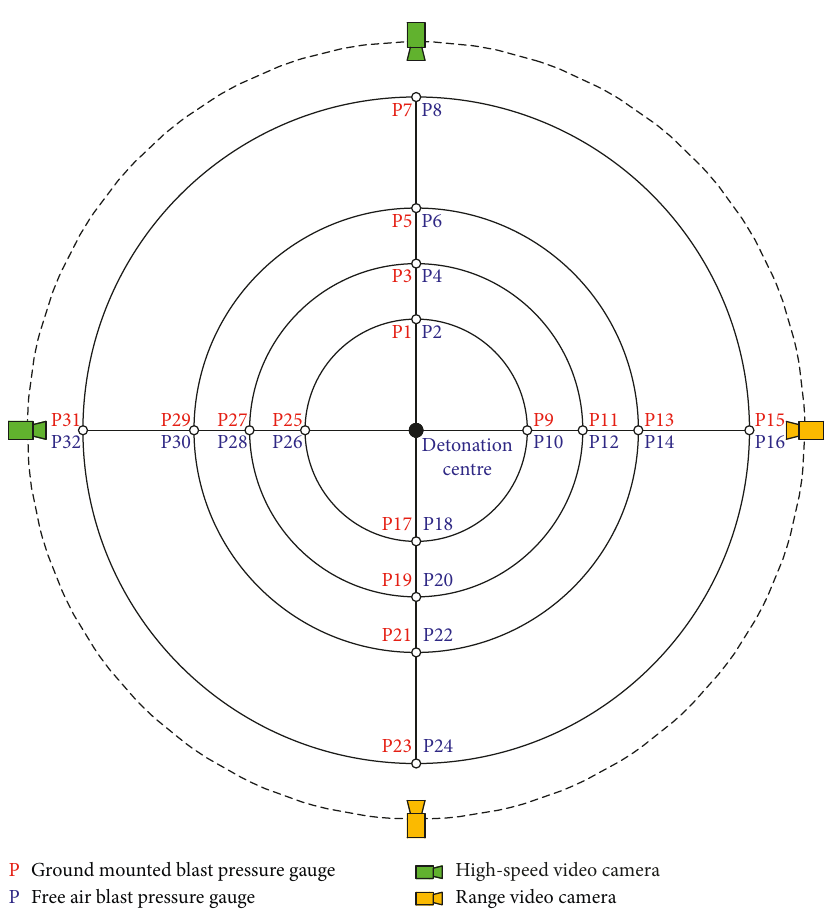
Figure 11: Scheme of the field blast sensors installation [91].